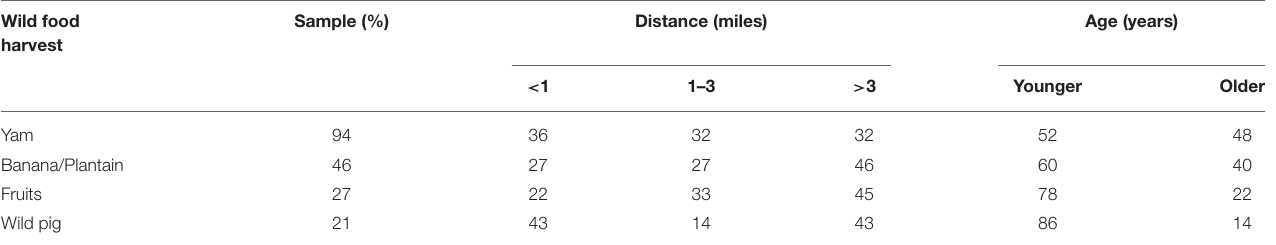
TABLE 2 | Wild food harvest by distance and age. Wild food